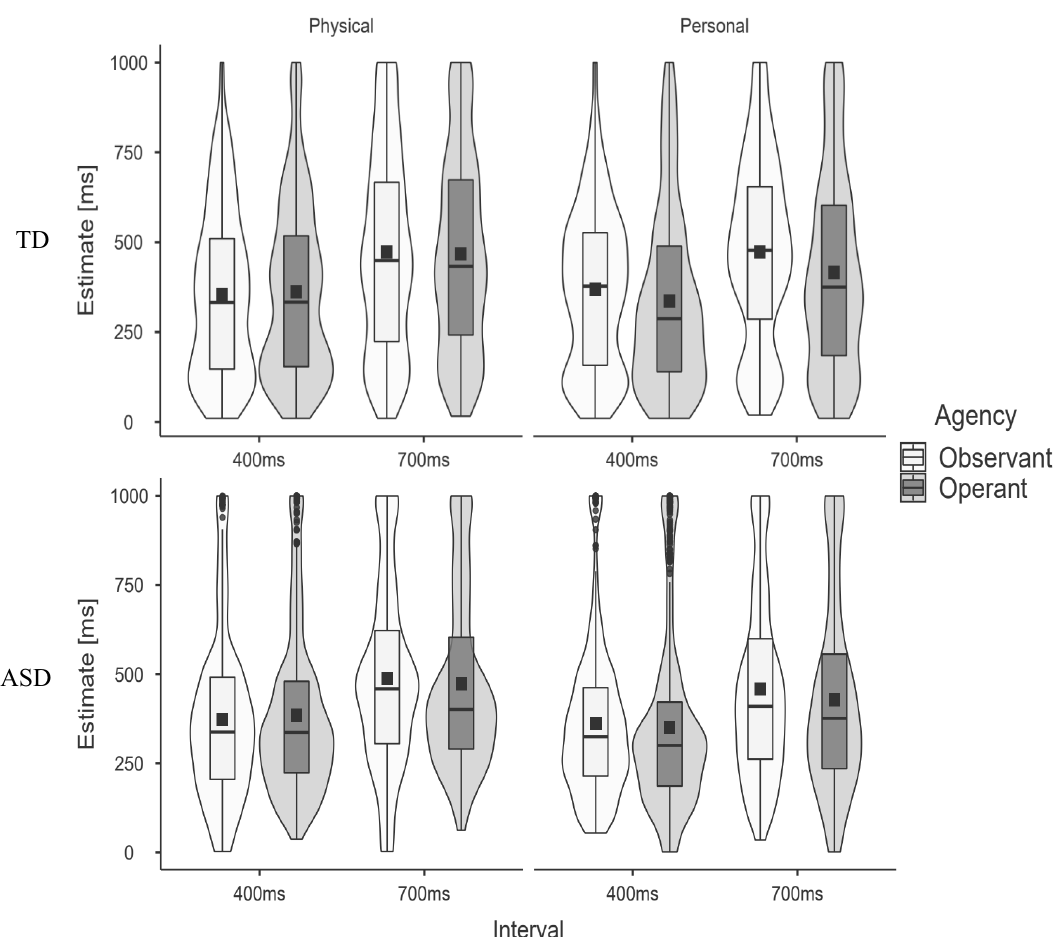
Figure 3. Results for Experiment #1. The top row depicts estimates from the TD group. The bottom row depicts estimates from the ASD group. Plots on the left depict estimates for physical conditions. Plots on the right depict estimates for personal conditions. Time estimates for 400 ms interval conditions are shown in the left columns; those for 700 ms interval conditions are shown in the right columns. Light grey indicates observant conditions, while dark grey indicates operant conditions. Outliers (depicted as black dots) correspond to individual participant’s estimates and reflect grouping around individual anchor points. Social hyperbinding is visible in the relatively lower estimates of operant trials as compared to observant trials for personal conditions. Hyperbinding is lower for the ASD